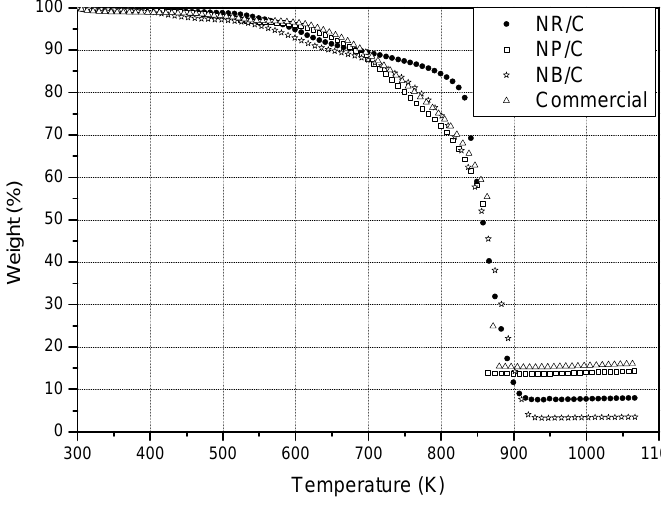
Figure 2. TGA curves of commercial Pd/C, NR/C, NB/C, and NP/C